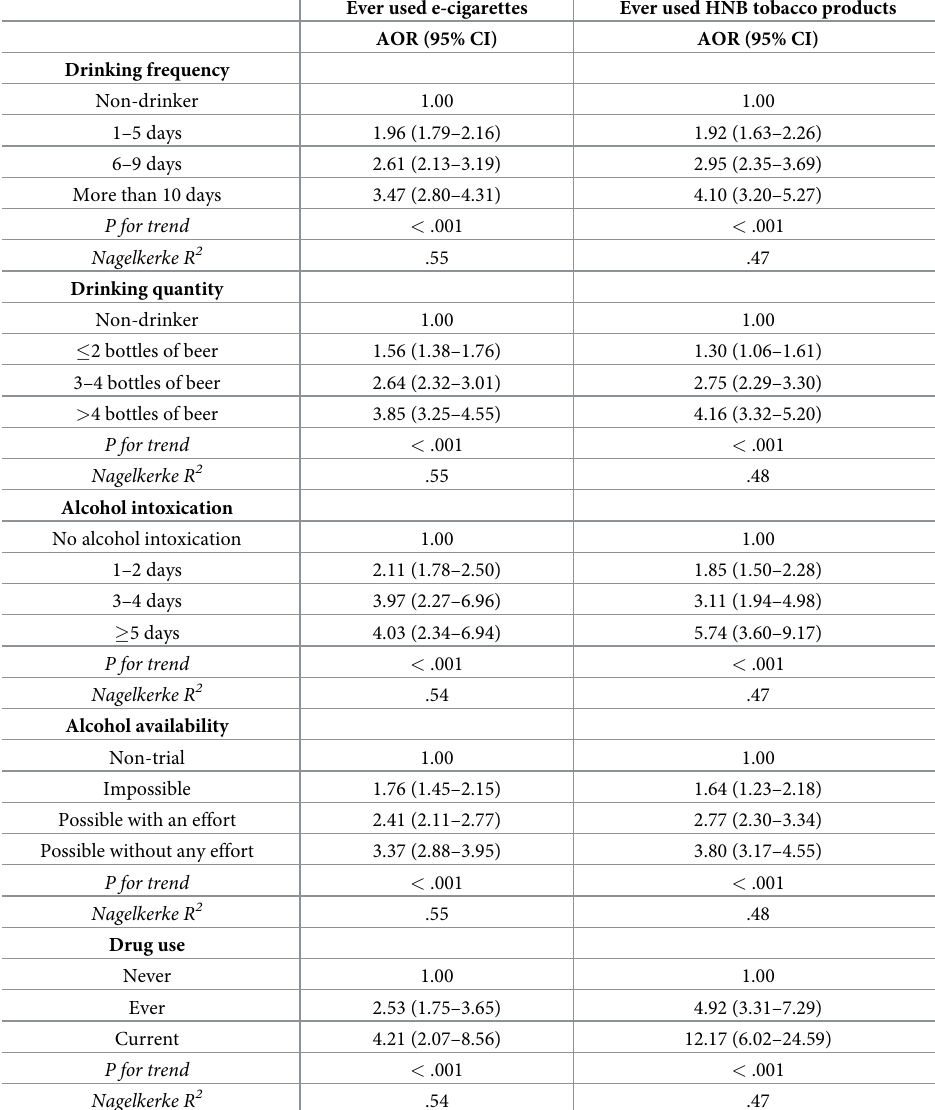
Table 3. Alcohol-related behaviors and drug use among Korean adolescents who had ever used e-cigarettes or HNB tobacco products (N = 60,040) 1